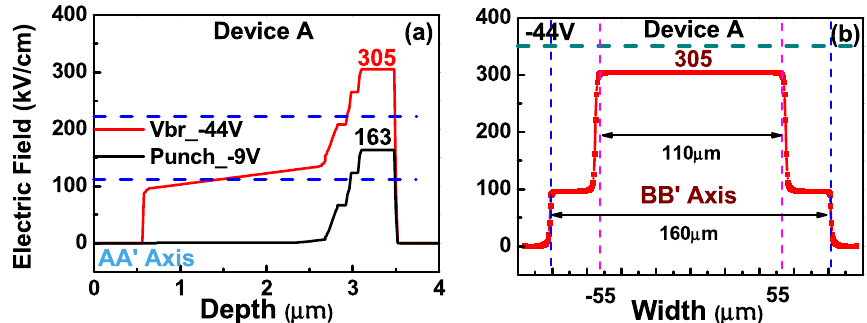
Figure 2. Electric field profiles at V pt and V br for device A along the directions. ( a ) AA ′ . ( b ) BB ′ .